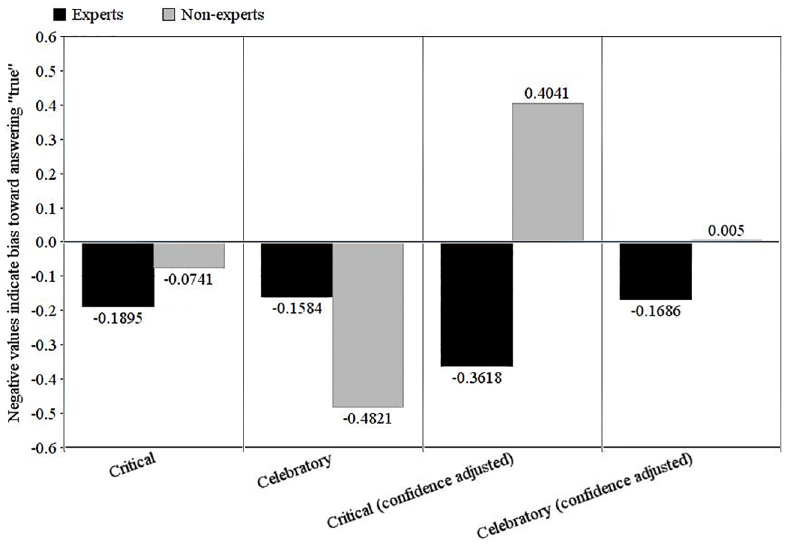
Figure 2. Criterion